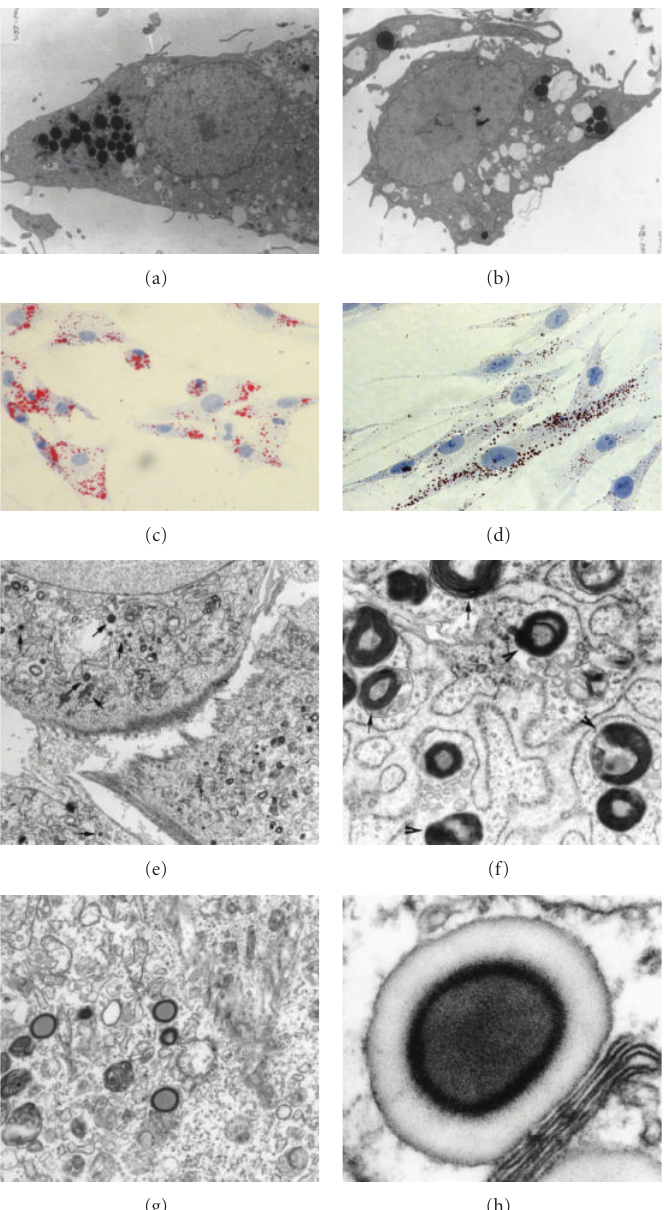
Figure 1: Morphological analysis and comparison of PSC and hPFC. (a) Pancreatic stellate cells after 3 days of adherence fixed with glutaraldehyde/malachite green to preserve lipid droplets. (original magnification: 3000x). (b) PSC in standard fixation showing layered lipid droplets (original magnification: 3000x). (c) Oil red staining of PSC after 3d in culture (original magnification: 200x). (d) Oil red staining of human pancreatic fibroblastoid cells (hPFCs) after 3 passages (original magnification: 200x). (e)–(h) Electron microscopy analysis of hPFC in standard fixation after 3 passages. (e) Section of three adjacent cells showing dense cytoskeletal structures at sites of adhesion. Throughout the cytoplasm, multilamellar vesicles and round layered entities (arrows), can be seen (original magnification: 3000x). (f) Multilamellar vesicles at higher magnification (20000x) show di ff erent stages of membrane degradation. While some structures show stacked lipid bilayers (arrow), others contain electron-dense “molten” membrane in addition to fuzzy, lighter material (arrowheads). (g) Picture shows layered lipid entities next to multivesicular lysosomal/autosomal structures (original magnification 7000x). (h) High magnification view (85000x) of layered entity reveals these structures as nonmembrane-bounded lipid